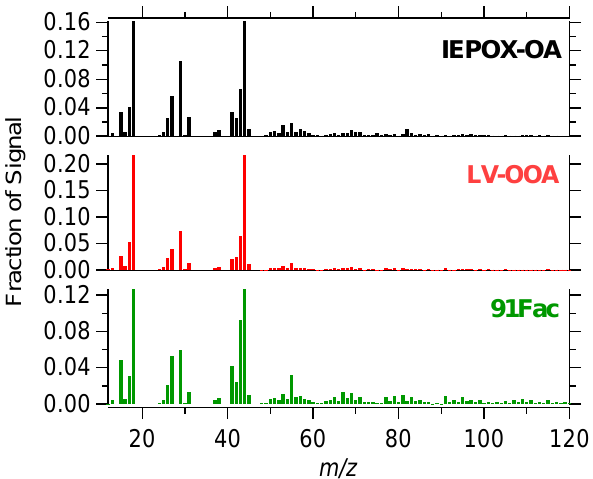
Figure 2. Mass spectra obtained for the 3-factor solution from PMF: IEPOX-OA, LV-OOA, and 91 Fac.